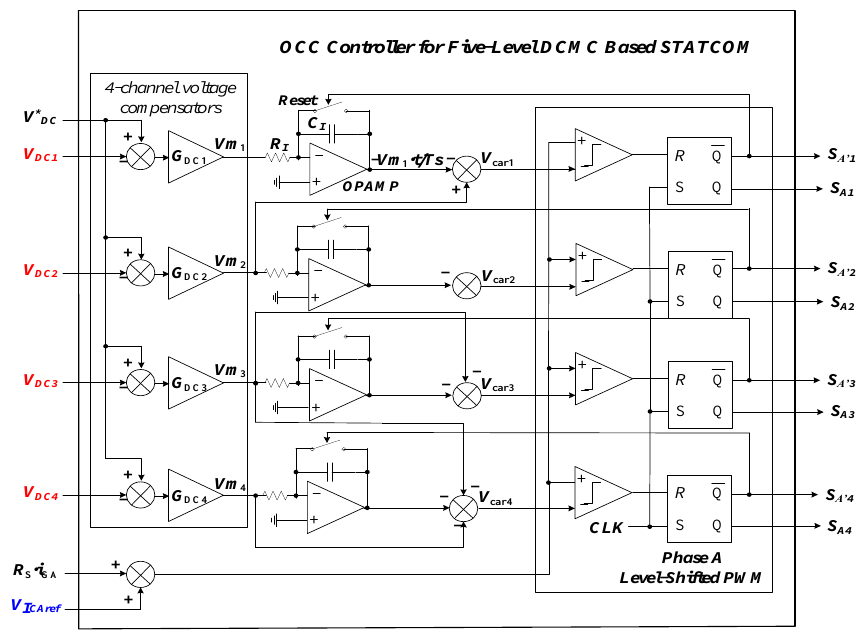
Figure 3. OCC control circuit of the five-level DCMC-based STATCOM for Phase A. Using the four integrators with reset and three adders, the four level-shifted carrier signals ( V car 1 - V car 4 ) are generated with the different amplitudes and dc-level shifts. The proposed level-shifted carrier signals can be respectively represented as follows: